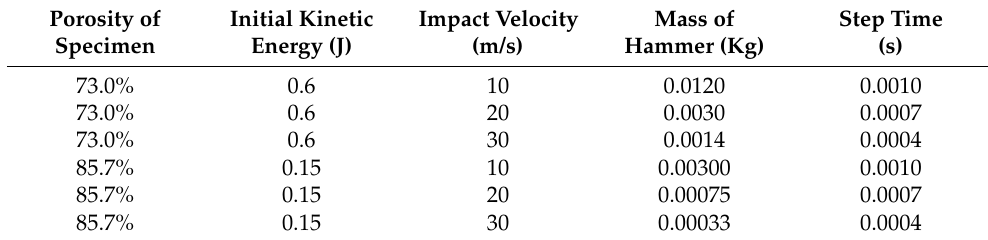
Table 1. Parameters settings for the impact simulation.